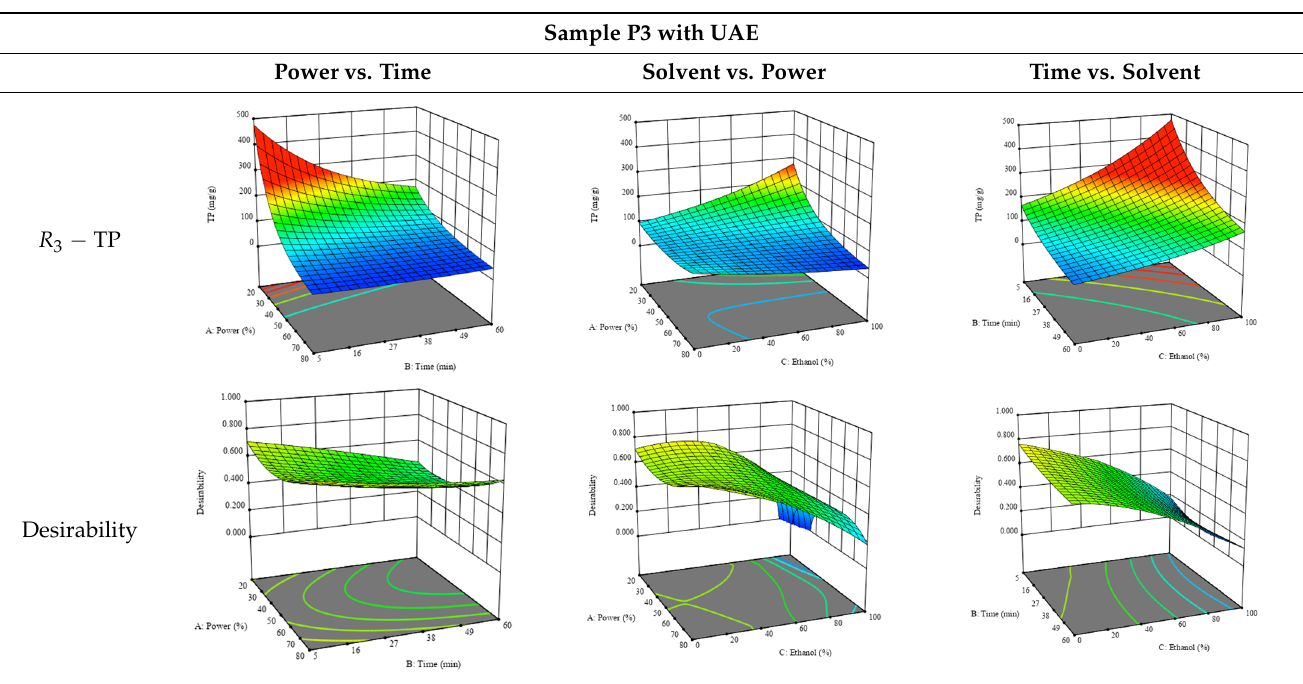
Sample P3 with UAE